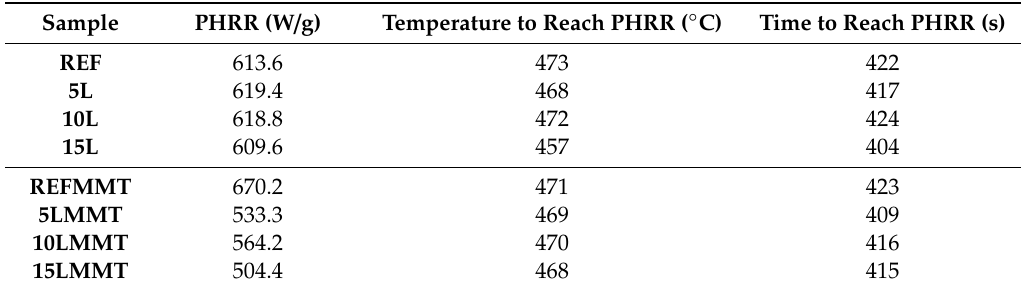
Table 5. Point of heat release rate (PHRR) parameters for the materials coated utilizing the LbL method.